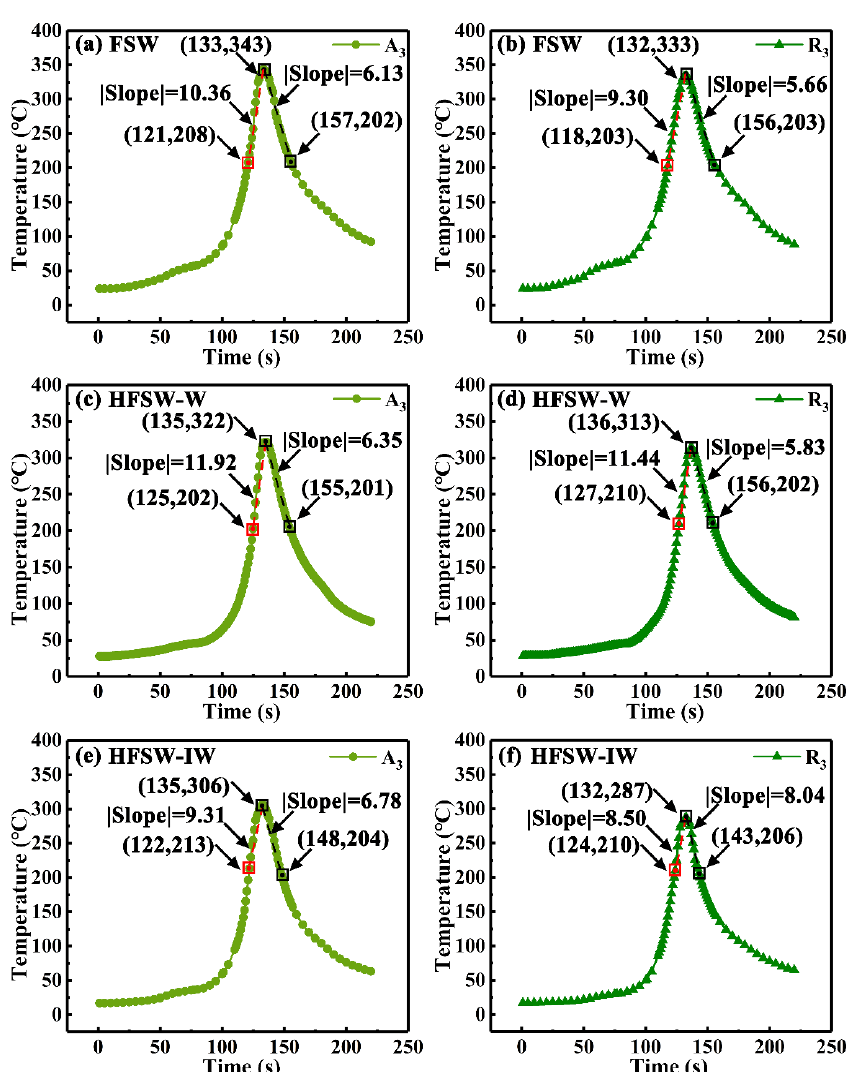
Figure 5. The thermal cycle curves of: ( a ) feature point A 3 under the FSW condition; ( b ) feature point R 3 under the FSW condition; ( c ) feature point A 3 under the HFSW-W condition; ( d ) feature point R 3 under the HFSW-W condition; ( e ) feature point A 3 under the HFSW-IW condition; ( f ) feature point R 3 under the HFSW-IW